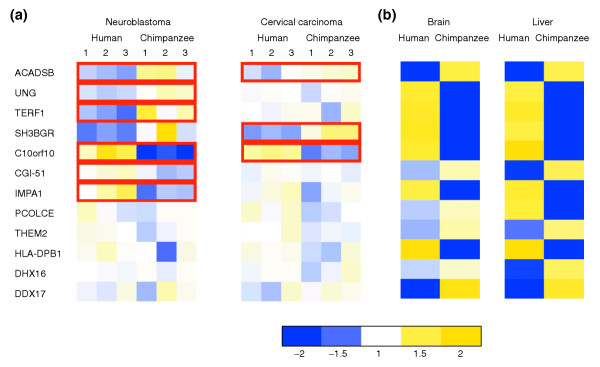
Human and chimpanzee promoter activity and mRNA expression in tissues. (a) Promoter activity in cell cultures. Normalized activities of promoters of the indicated genes are compared to the average of the three human and the three chimpanzee clones for each cell line and promoter indicated. Blue indicates lower activity than average, whereas yellow indicates higher activity. The color scale for the fold-change is below. Significant differences in activity between the two species are indicated by red frames. (b) Expression of the genes in tissues as assayed by mRNA levels measured by oligonucleotide arrays for brain and liver [6]. The values are averages of the three human and three chimpanzee individuals for which expression levels were determined [6] and are compared to the average level of the corresponding gene.